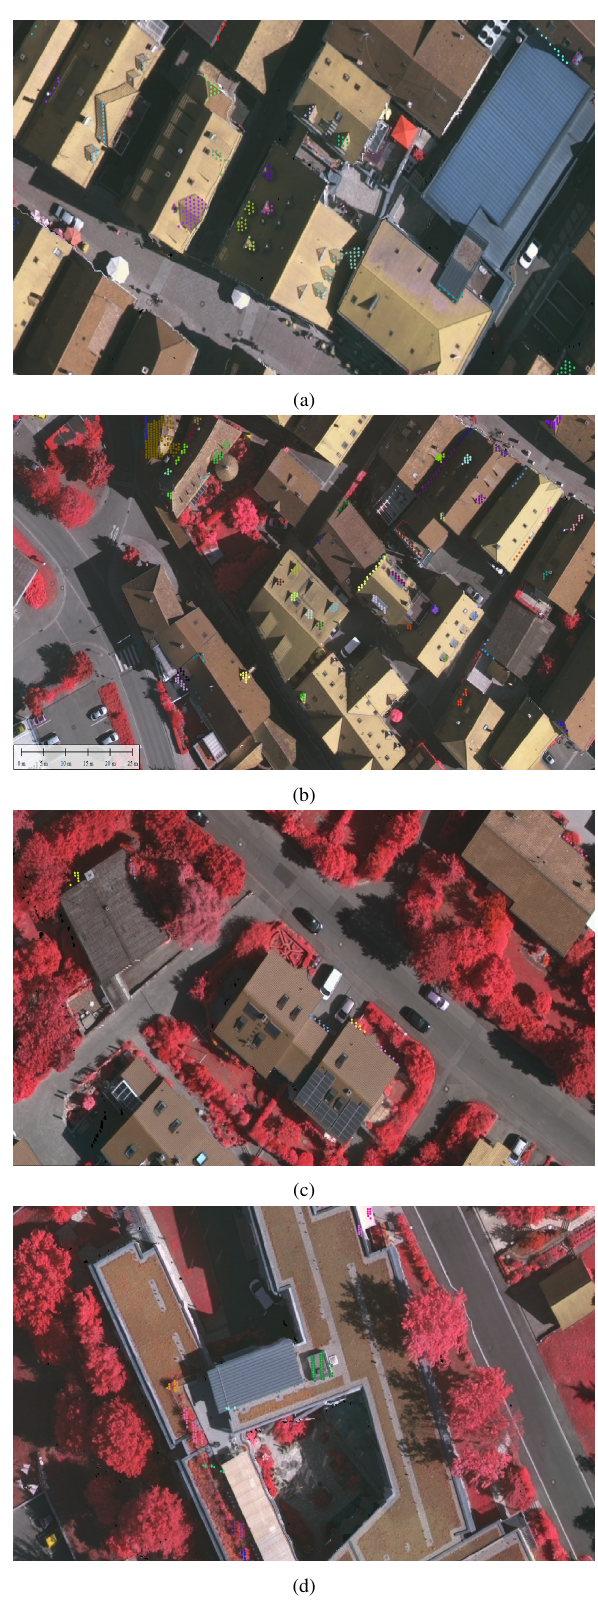
Figure 6. Component projected over orthophoto. (a) Gable dormers (b)Shed dormers. (c) Ground. (d)